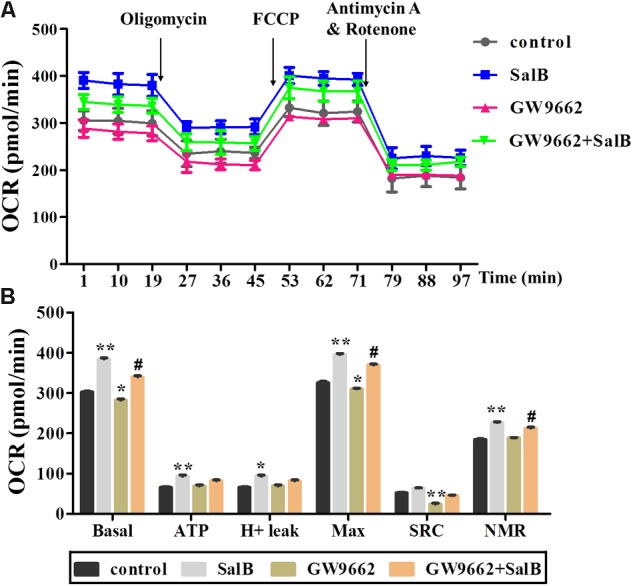
Effects of SalB (50 μM) and/or GW9662 (20 μM) on oxygen consumption rate (OCR) in 3T3-L1 cells. (A) Represents OCR curves obtained from different conditions. (B) Represents: Basal, basal respiration; ATP, ATP production; Max, maximum respiration; SRC, spare respiration capacity; H+ leak; and NMR, non-mitochondrial respiration of 3T3-L1 adipocytes under different treatments, respectively. Data are represented as mean ± SEM of three independent experiments. ∗p < 0.05 and ∗∗p < 0.01 versus control group, #p < 0.01 and ##p < 0.01 versus GW9662 group.